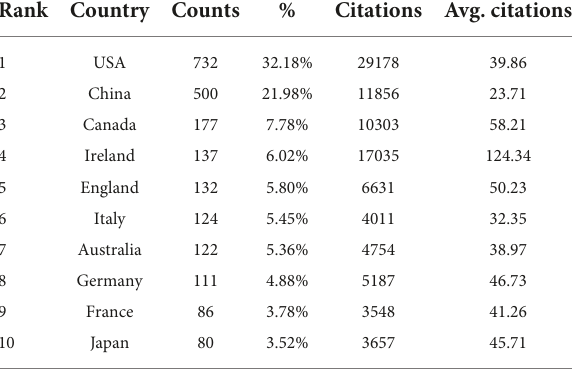
TABLE 1 The top 10 countries/Regions to study the gastrointestinal microbiome and